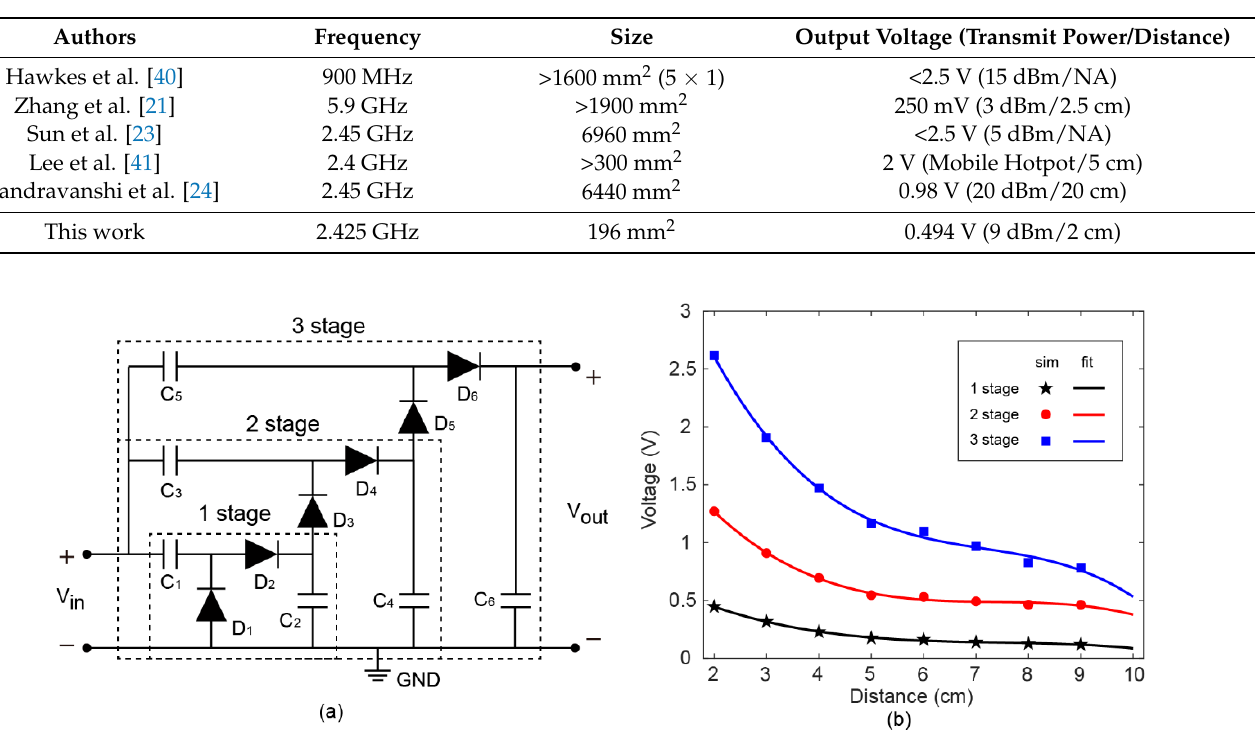
Figure 7. ( a ) The schematic of the N-stage Dickson voltage multiplier (N = 1, 2, 3). ( b ) Simulated output DC voltage (open circuit) versus distance under different stages of Dickson voltage multi- plier.